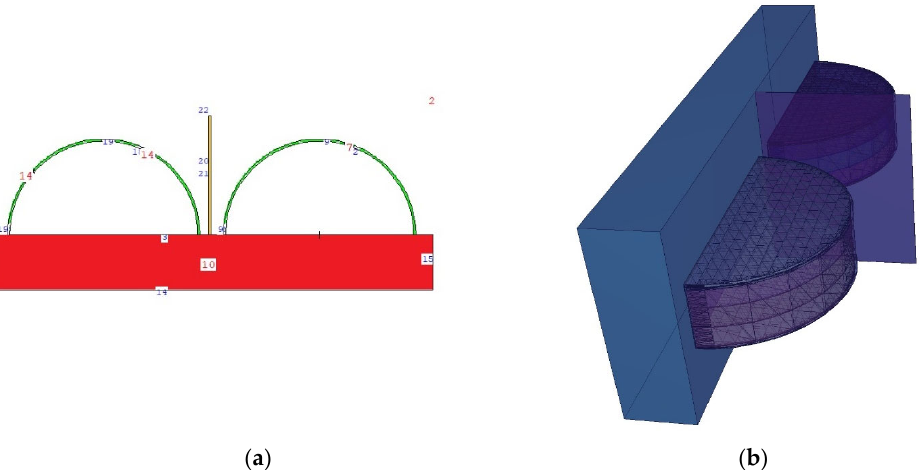
Figure 4. ( a ) Two ‐ dimensional view of modelled breast phantom, along with the location of shield ‐ ing screen ( b ) Three ‐ dimensional view of modelled breast phantom, along with the location of shielding